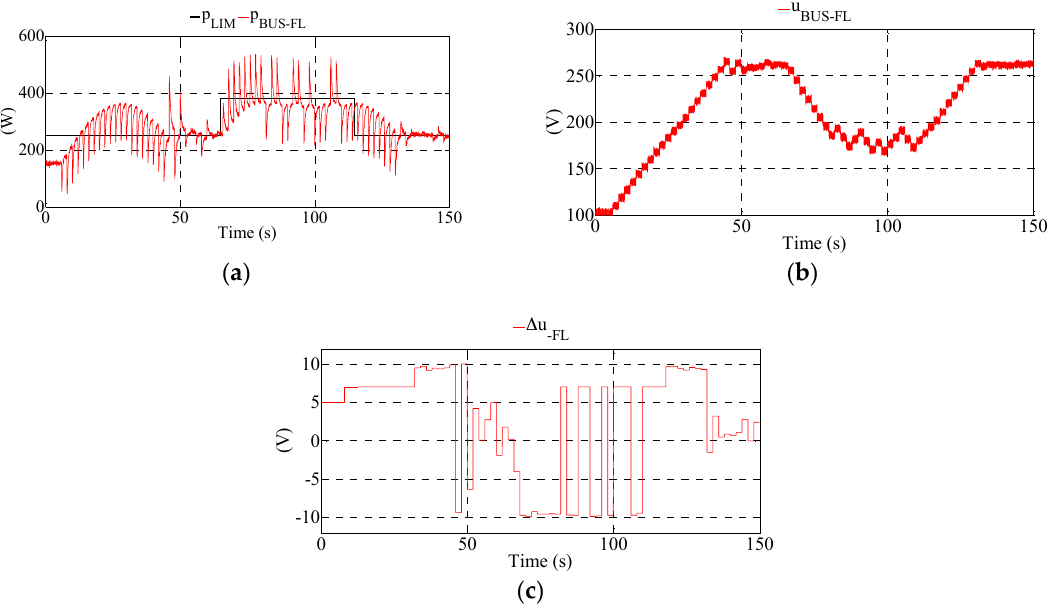
p ; ( b ) Evaluations of u ; ( c ) Evaluations of u  . BUS BUS